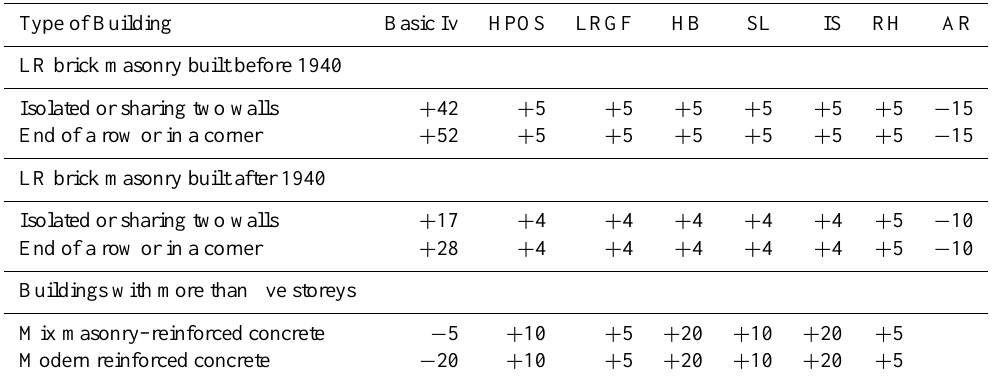
Table 3. Vulnerability index defined for the different types of buildings located in the region of Li`ege (Jongmans and Plumier, 2000; Plumier et al.,